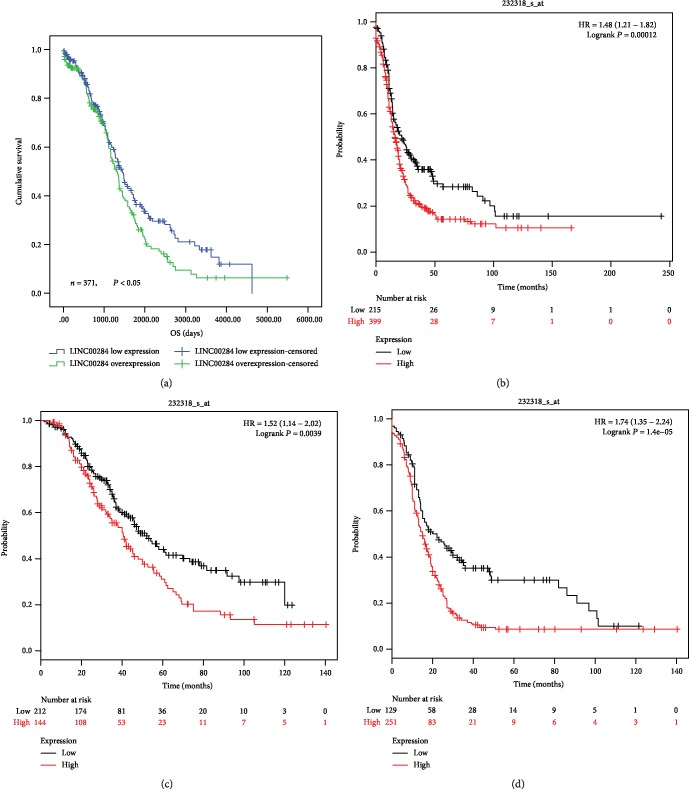
Analysis of the relationship between LINC00284 expression and prognosis in patients with serous ovarian carcinoma based on TCGA (a) and TCGA/GEO (b–d) datasets. (a, b) Patients with LINC00284 overexpression had shorter overall and progression-free survival than those with low LINC00284 expression (P < 0.05 and P < 0.001, respectively). (c, d) Patients with serous ovarian carcinoma (SOC) and LINC00284 overexpression treated with chemotherapeutic drugs including taxol/platin combinations had shorter overall and progression-free survival (P < 0.01 and P < 0.0001, respectively).